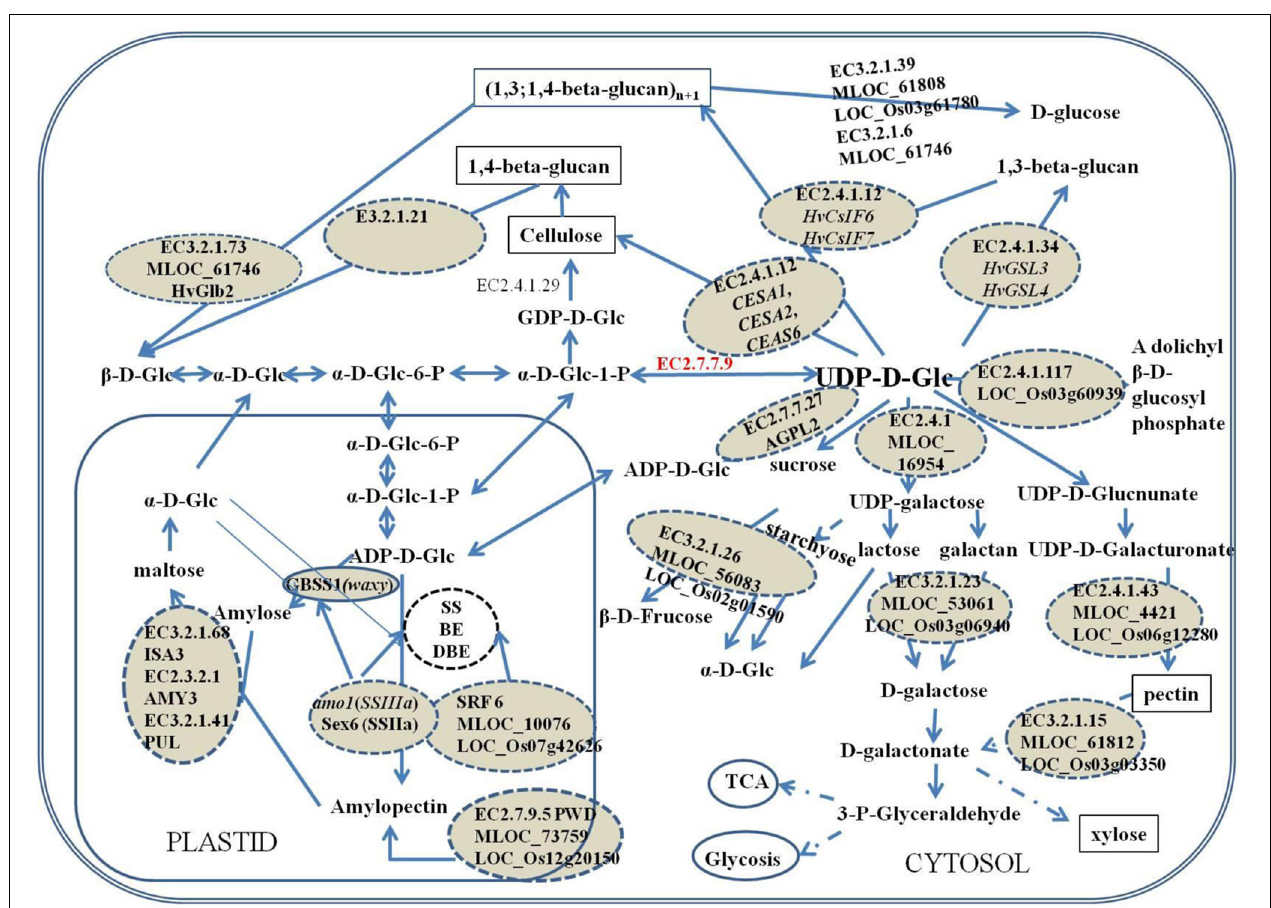
FIGURE 4 | Putative functions of the candidate genes in the co-regulated metabolite network of starch and β -glucan. The candidate genes and their encoding protein were dashed circled. The cell wall components were marked by black box. The dash arrows indicated there were no a single step. EC3.2.1.73: (1,3; 1,4)- β -glucanase; EC3.2.1.21: β -1,4-glucosidase; EC3.2.1.39: glucan-1,3- β -glucosidase; EC3.2.1.6: glucan-1,3- β -glucosidase; EC2.1.4.12: Cellulose synthase; EC2.4.1.34: glucan